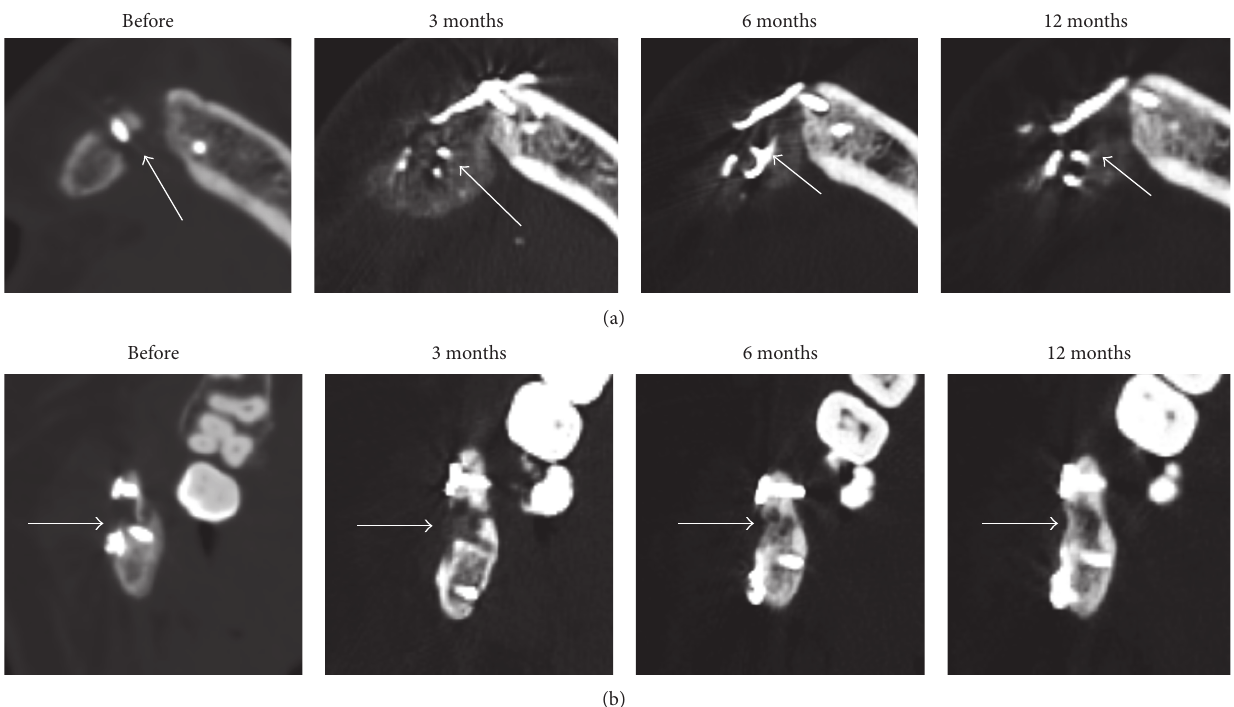
Figure 1: CT scans of the patient’s mandible in the frontal region (a) and within the ramus on the right side (b) prior to the operation and 3, 6, and 12 months after surgery. Arrows indicate nonunions (before operation) and the sites of gene-activated bone substitute implantation.